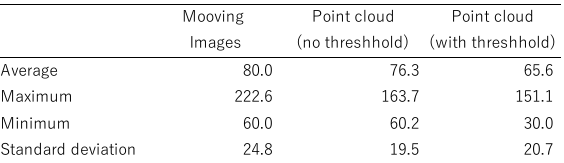
Table 2 . the statistics for each analysis value by VQM.